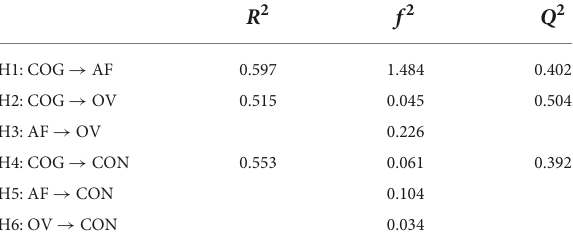
TABLE 9 The results of the prediction